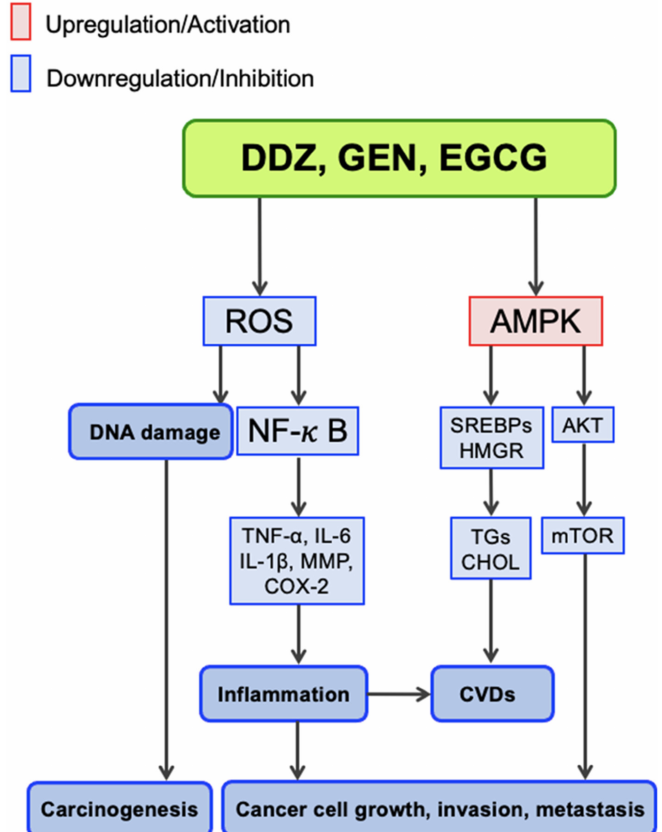
Figure 5. A putative major mechanism by which flavonoids exhibit anti-CVD and anticancer